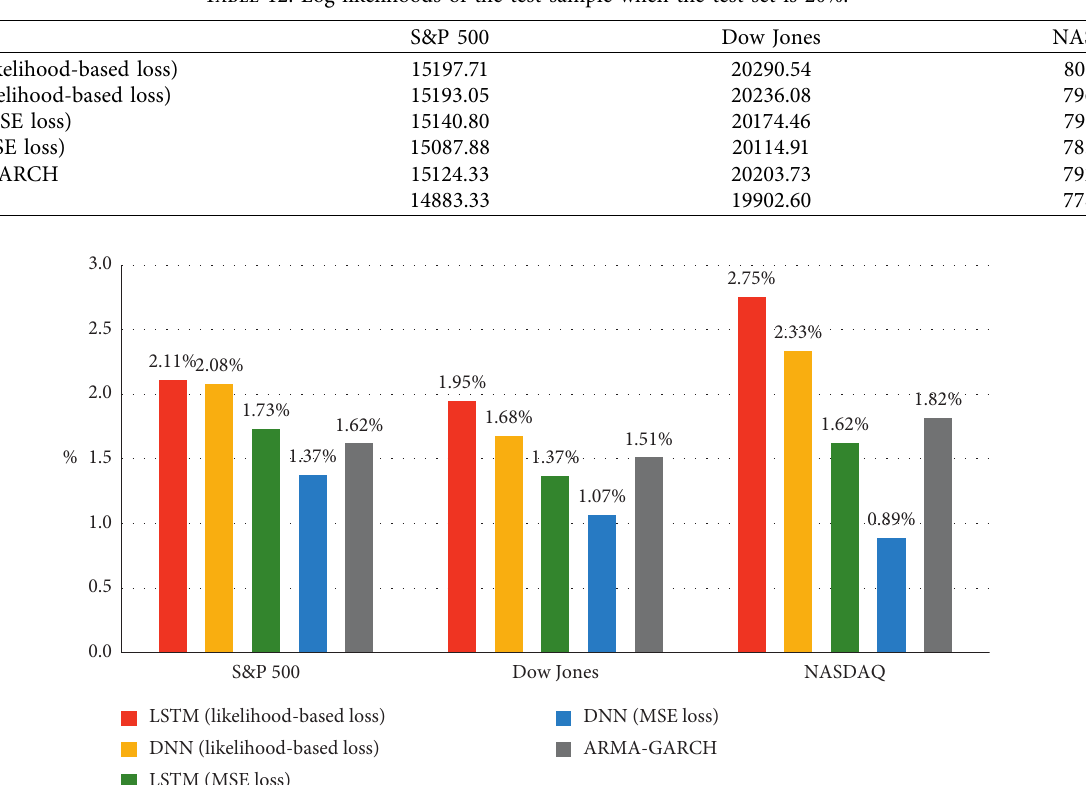
Table 11: Best window length to maximize the log likelihood when the test set is 20%. S&P 500 Table 12: Log likelihoods of the test sample when the test set is 20%.